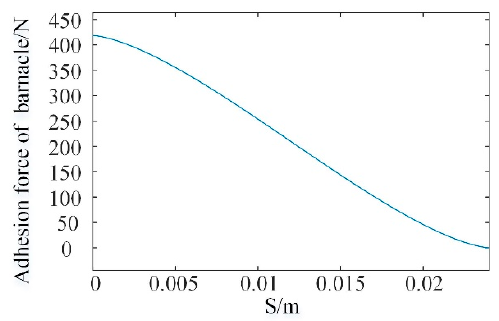
Figure 11. Adhesion force vs blade displacement with barnacle diameter d 1 = 0.24 mm.